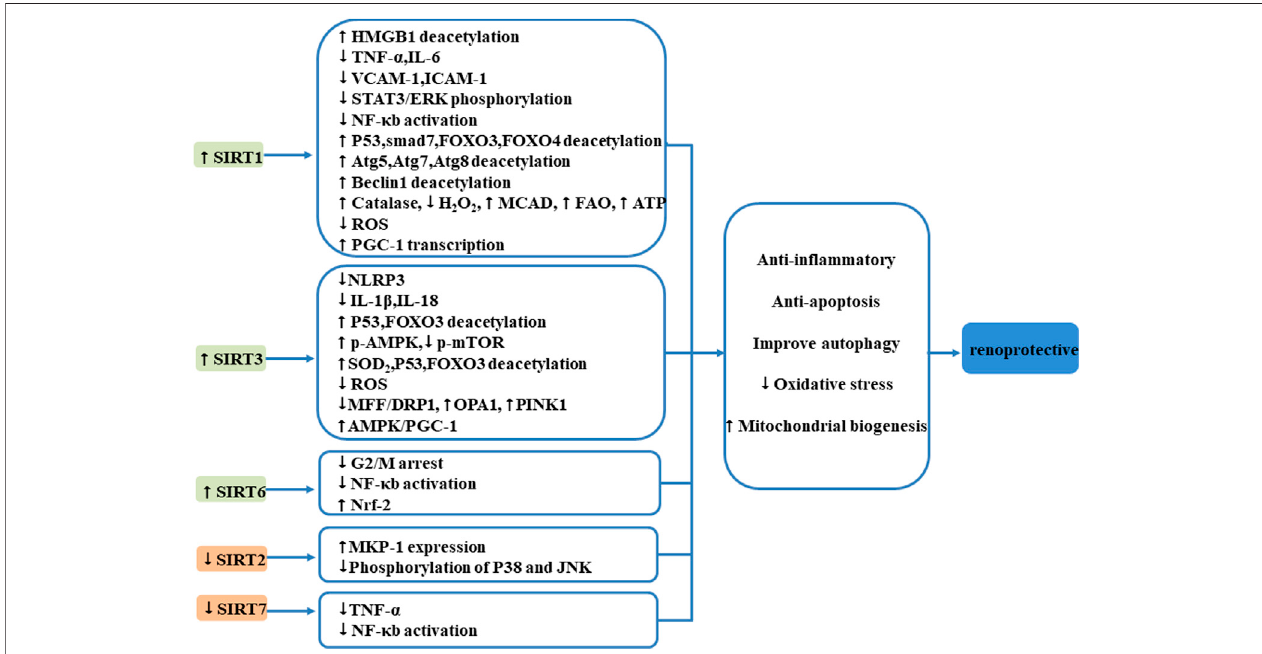
FIGURE 2 | Mechanism of SIRTs in fl uencing the kidney after AKI. Sirtuins play critical roles in cellular homeostasis, overexpression of SIRT1, SIRT3, and SIRT6, and suppression of SIRT7; SIRT2 is renoprotective. Sirtuins participate in acute kidney diseases through regulation of oxidative stress, apoptosis, in fl ammation, autophagy, and MB.